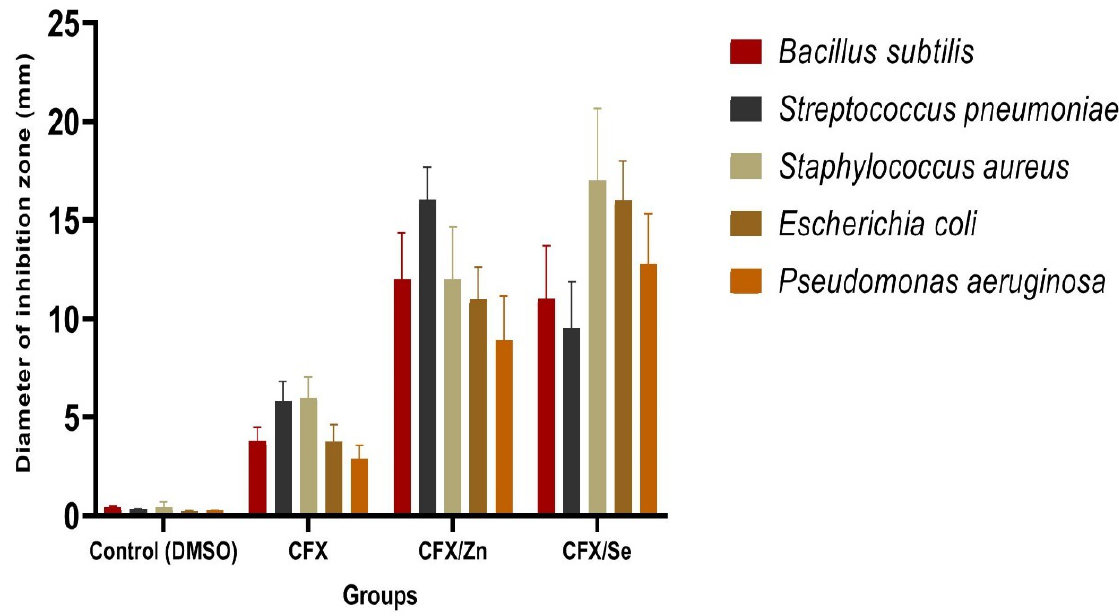
Figure 9. Antibacterial activity of CFX and Zn (II) and Se (IV) metal complexes .